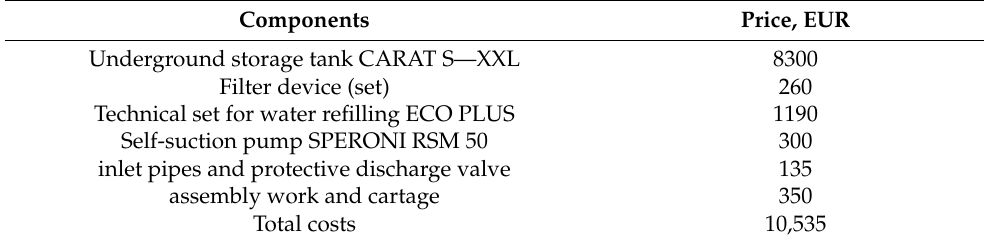
Table 4. Total costs of the proposed rain system.